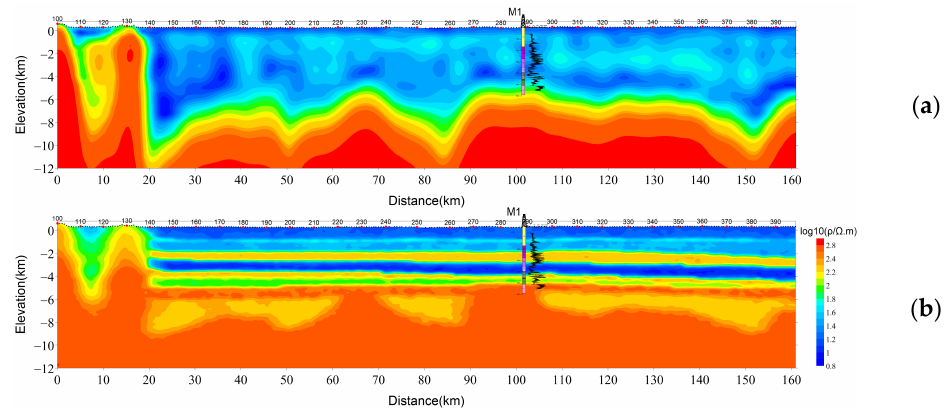
Figure 13. Conventional-2D-inversion result ( a ) and constrained-inversion result ( b ) of Line L1.